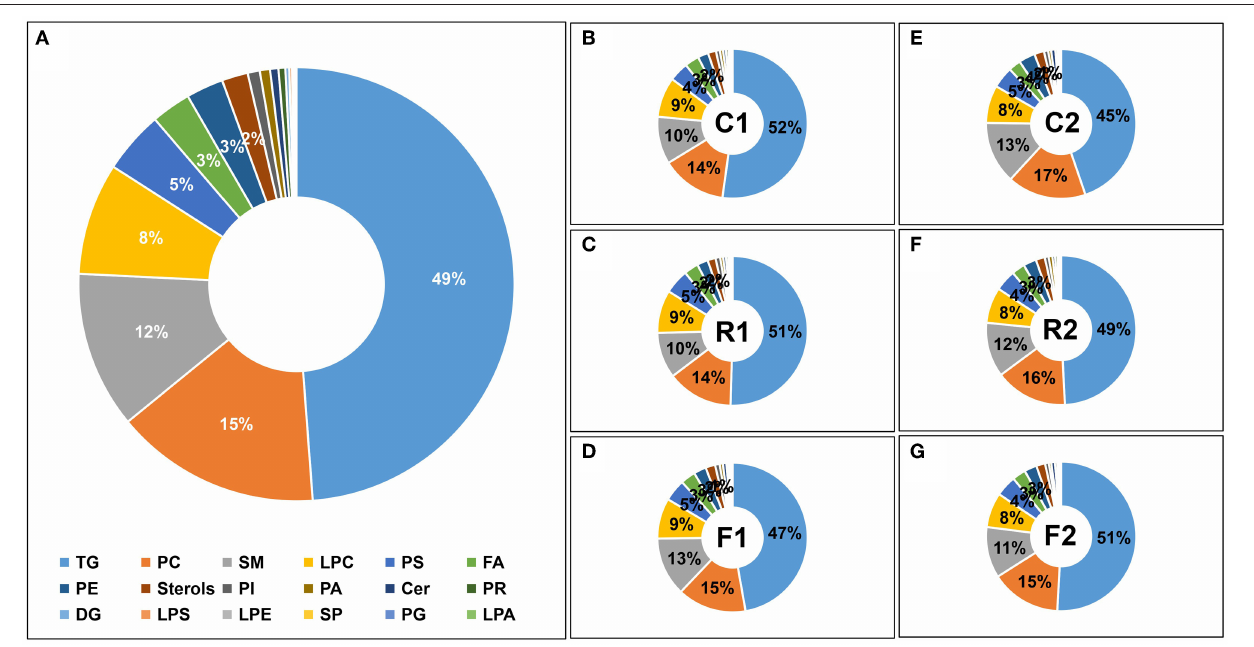
FIGURE 6 | Lipid classifications of the different diet types. Lipids were classified into 18 categories, including triacylglycerol (TG), phosphatidylcholine (PC), sphingomyelin (SM), lysoPC (LPC), phosphatidylserine (PS), fatty acids (FA), phosphatidylethanolamine (PE), Sterols, phosphatidylinositol (PI), phosphatidic acid (PA), ceramides (Cer), prenol lipids (PR), diacylglycerol (DG), lysoPS (LPS), lysoPE (LPE), sphingolipids (SP), phosphatidylglycerol (PG), and lysoPA (LPA). (A) Pie graph of the lipid classifications from the average of all samples. (B) Pie graph of lipid classifications from the control group at stage 1 (C1). (C) Pie graph of lipid classifications from the rice diet group at stage (R1). (D) Pie graph of lipid classifications from the flour diet at stage 1 (F1). (E) Pie graph of lipid classifications from the control group at stage 2 (C2). (F) Pie graph of lipid classifications from the rice group at stage 2 (R2). (G) Pie graph of lipid classifications from the flour group at stage 2 (F2). Note that numbers are not displayed for lipid percentages below